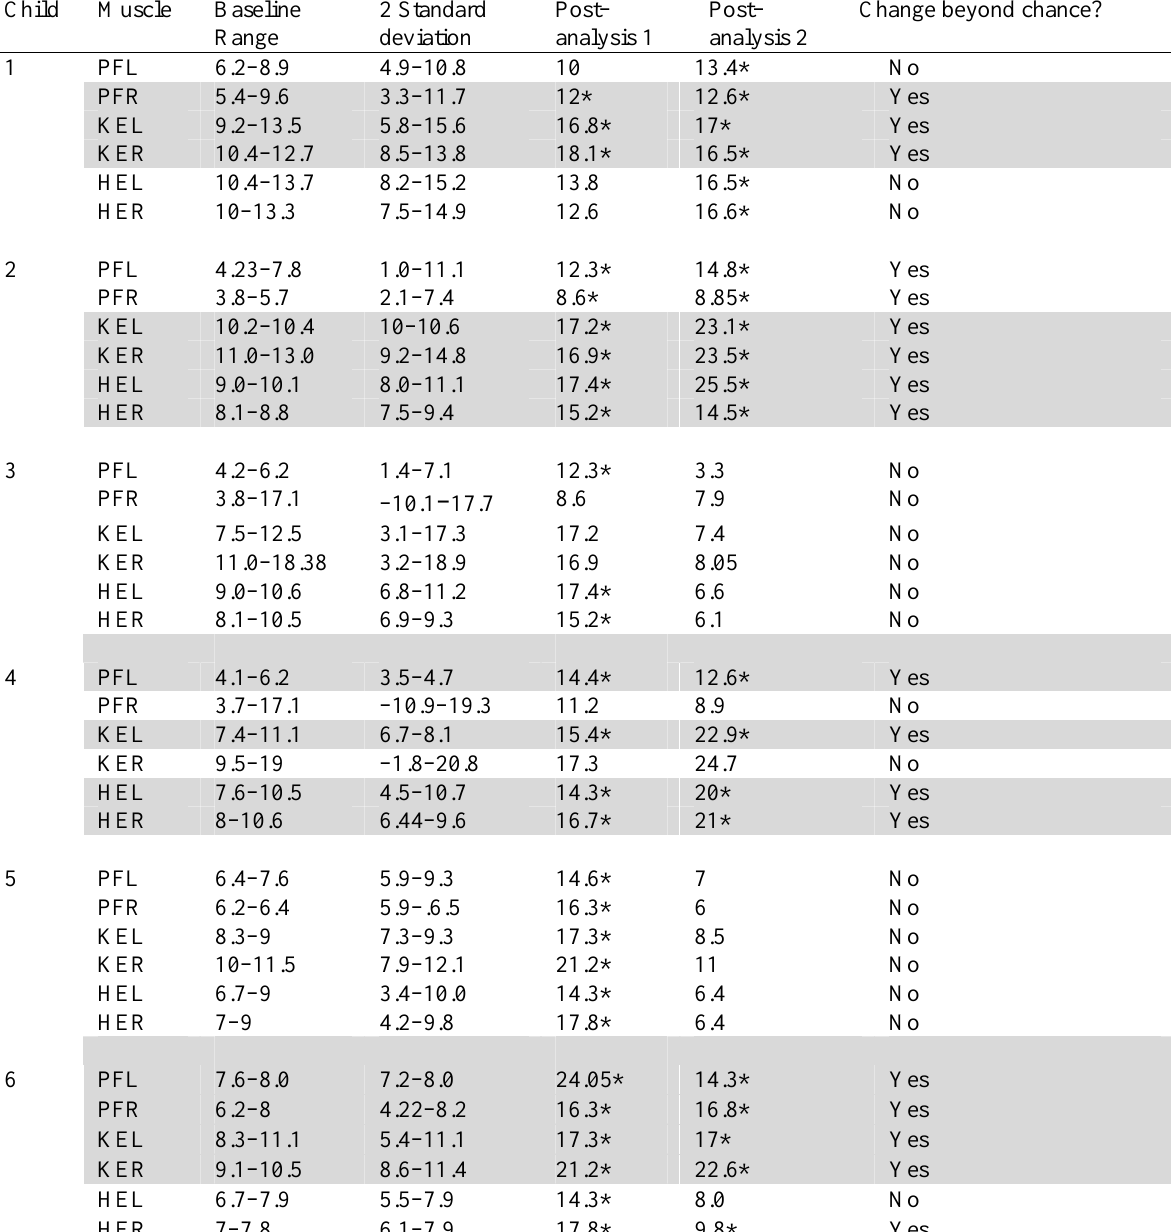
Pre and post–intervention strength